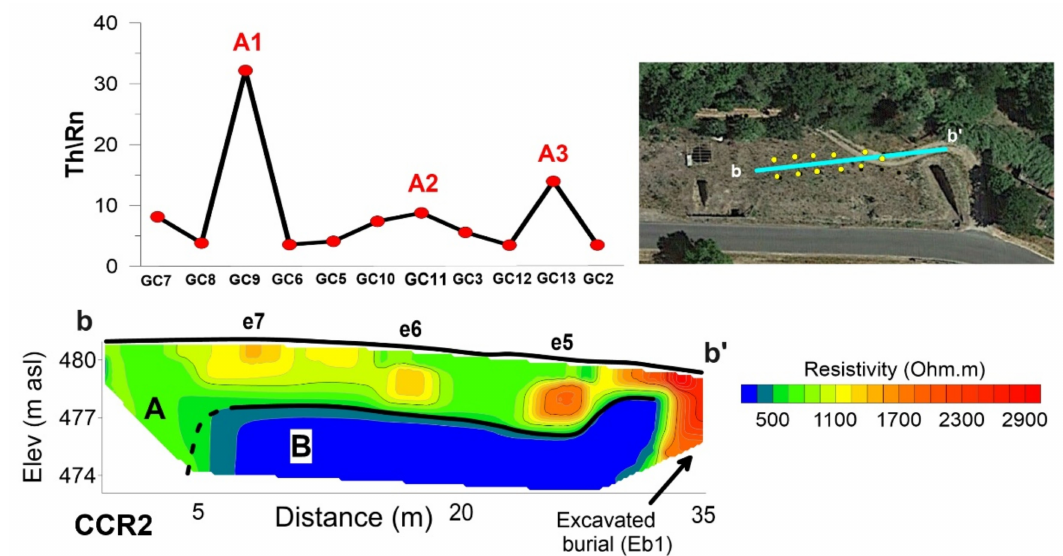
Figure 10. Geophysical and geochemical data comparison. Rn/Th values overlaid on the CCR1 profile (b-b’, see Figure 3 for profile location). Yellow dots in the satellite image locate the geochemical measurements selected to develop the Rn/Th ratio